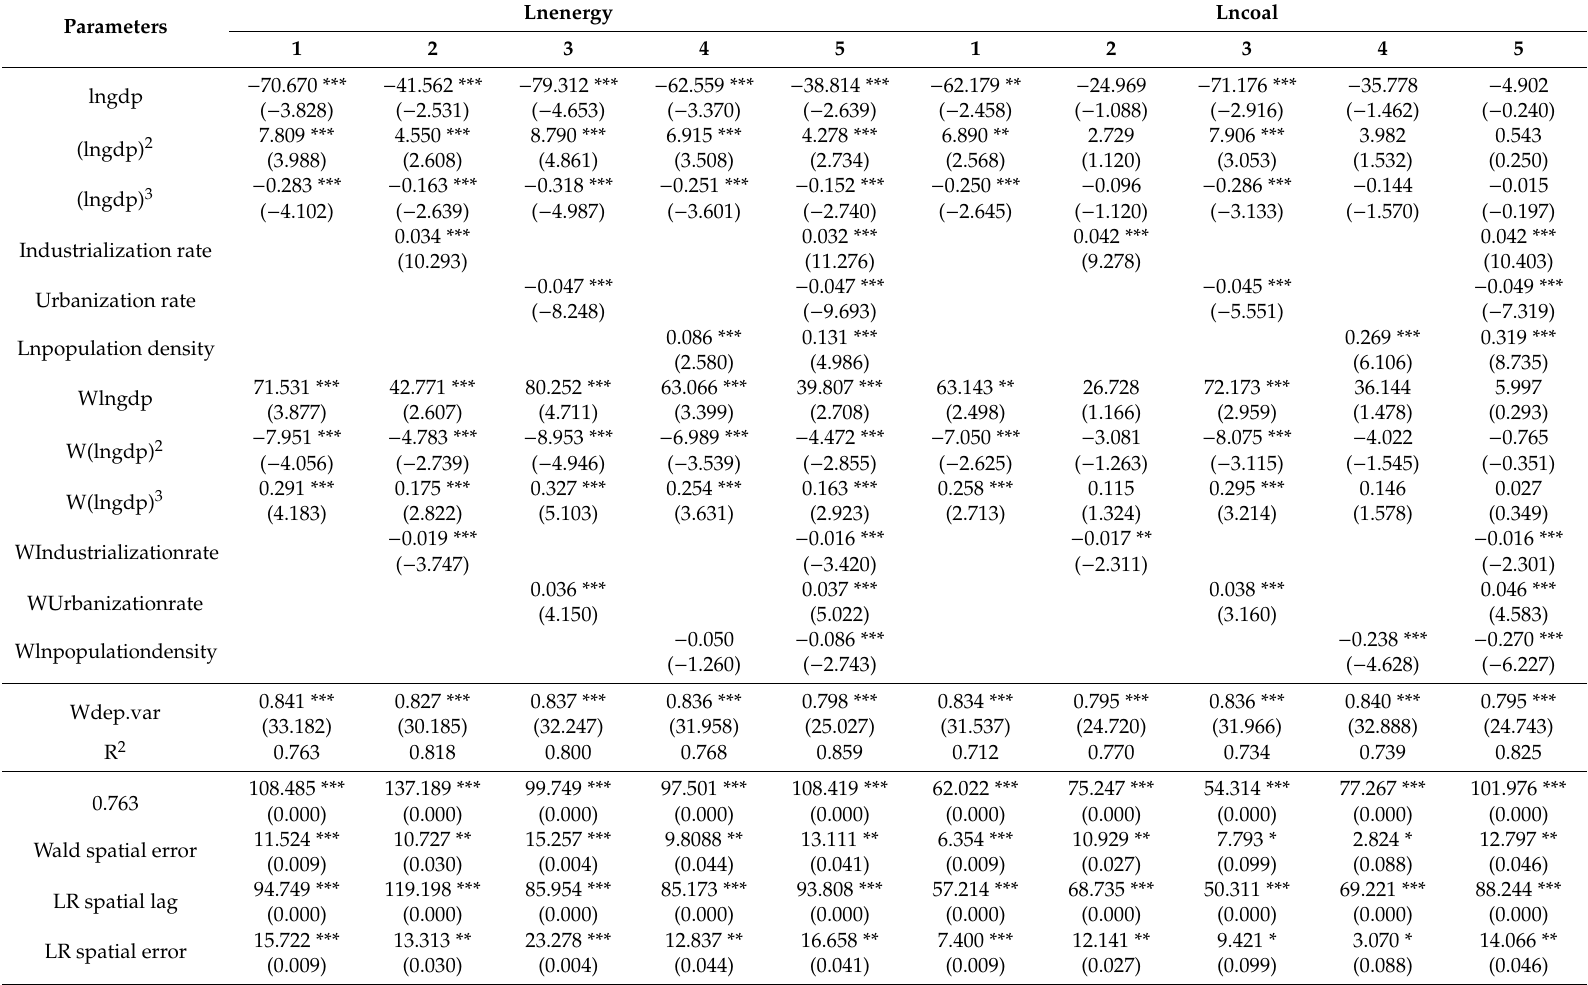
Table 8. Spatial Durbin model estimation results of total energy consumption and total coal consumption mixed OLS e ff